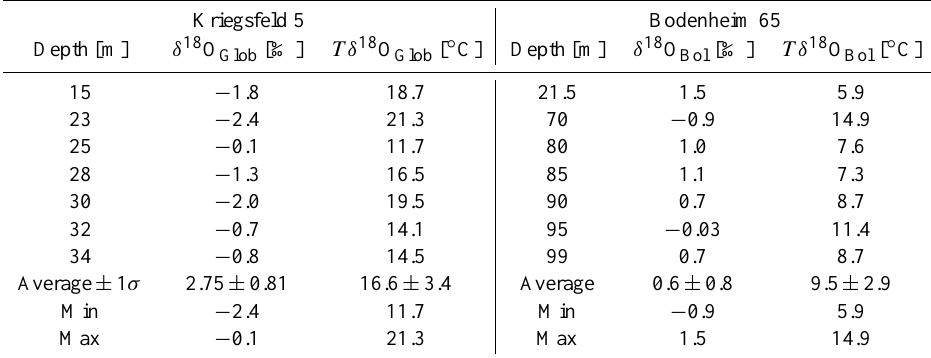
Table 4. Oxygen isotope values ( δ 18 O vs. VPDB) of foraminiferal tests from the Bodenheim formation (Kriegsfeld 5 and Bodenheim 65 well) reported by Grimm (1994). δ 18 O Glob is Globigerina sp. (planktonic foraminifera); δ 18 O Bol is Bolivina sp. (benthonic foraminifera). Values have been converted to temperature ( T δ 18 O Glob , T δ 18 O Bol ) using the equation by Anderson and Arthur (1983) assuming δ 18 O w =−